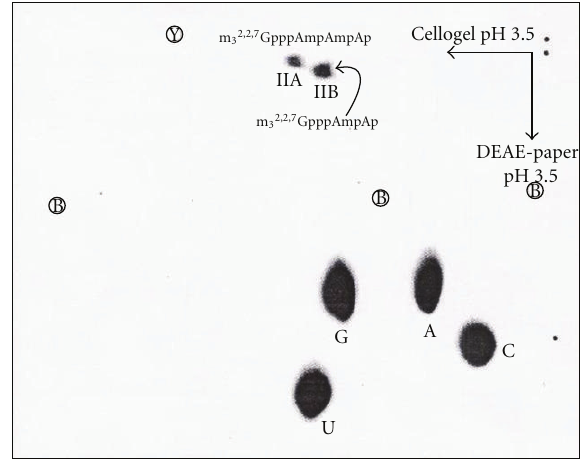
Figure 29: 2D map of U3 RNA digest [58]. The [ 32 P]-labeled U3 RNA was digested with T 2 RNase and U 2 RNase. It produced two 5 (cid:2) fragments “11A” and